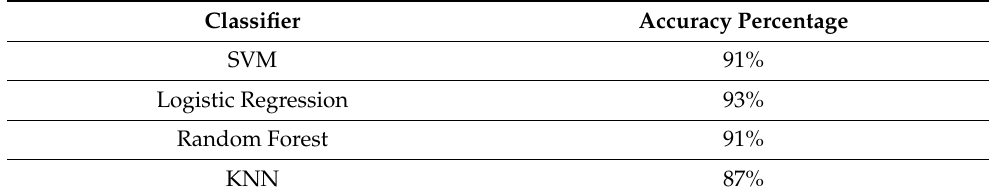
Table 8. Accuracy for each